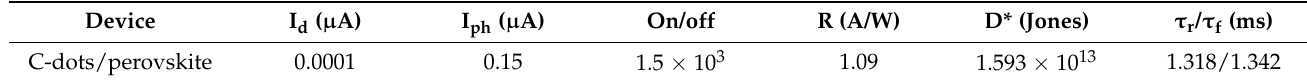
Table 1. Performance summary of the C-dot/perovskite photodetector.